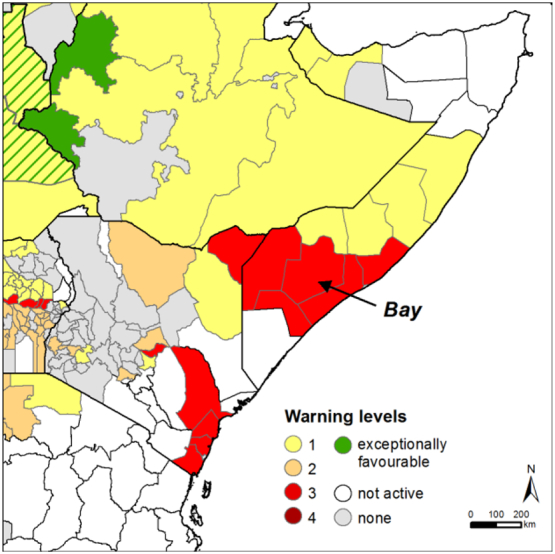
Warning map as of 20-Oct-2016 for Somalia, Kenya and Ethiopia.